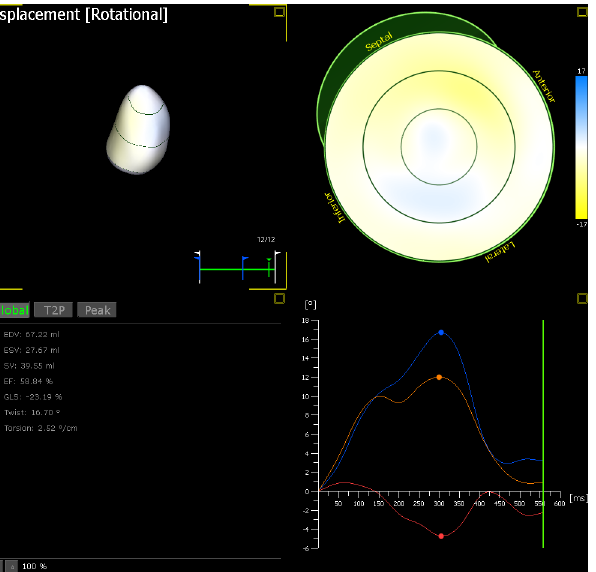
Fig 2. The analysis of LV rotation at apical (orange line), rotation at basal (red line) and twist (blue line) variables can be derived and displayed.